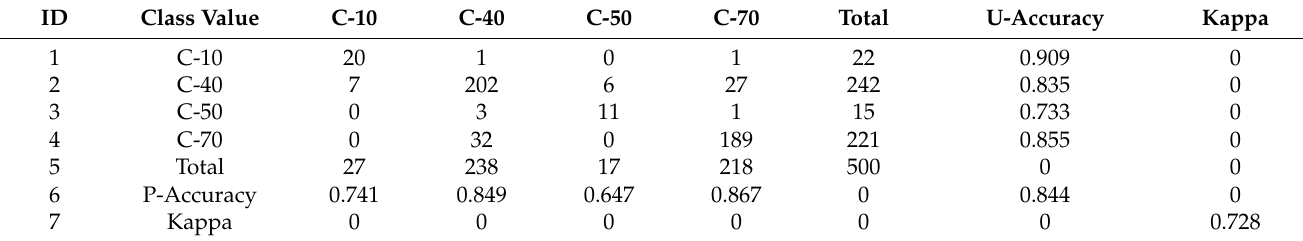
Table A3. ArcGIS Pro confusion matrix of the SVM classification map generated from LiDAR data.